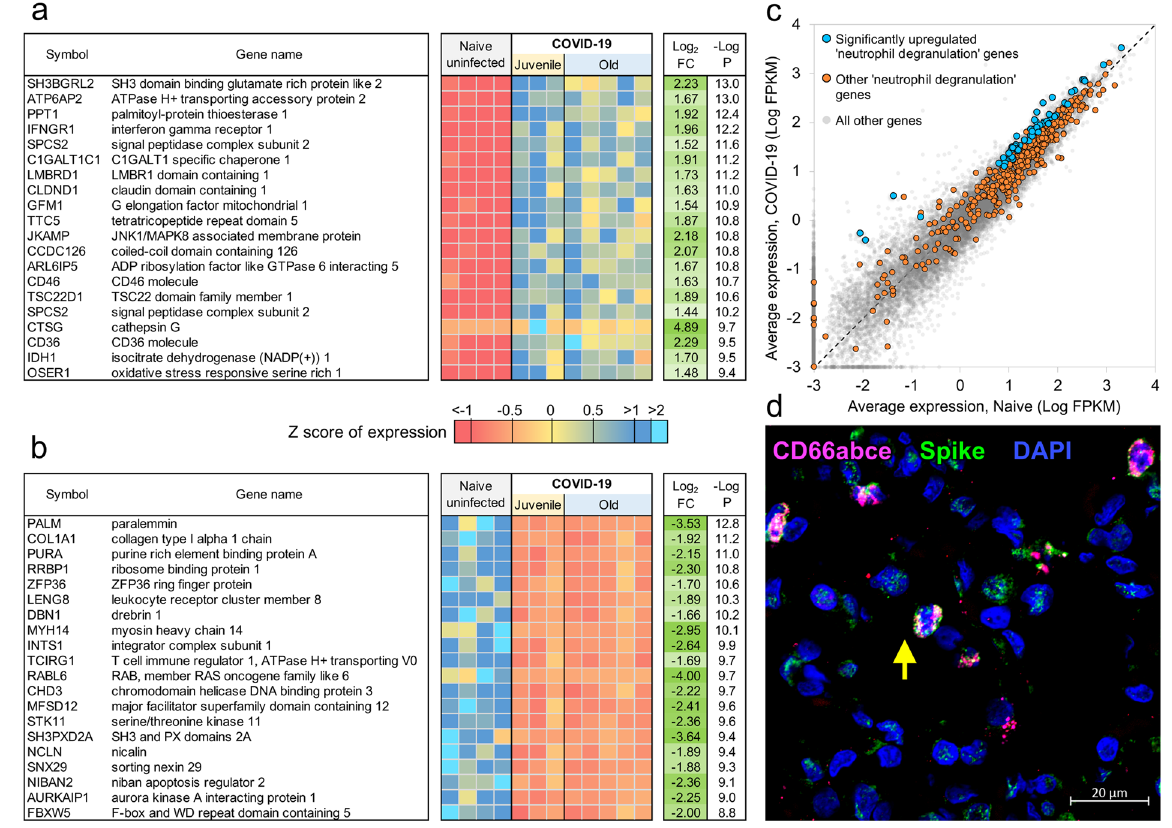
Fig. 2 Genes differentially regulated in SARS-CoV-2-infected macaques represent pathways characteristic of neutrophil degranulation, IFN signaling, collagen degradation and TFG- β signaling. The top 20 most signi fi cantly a upregulated genes and b downregulated genes in SARS-CoV-2-infected macaque lungs. Expression values are visualized by Z scores of normalized expression data (FPKM) per sample, and Log 2 Fold Change and -Log P values are from the DESeq2 output. Genes are sorted by P value. c Gene expression plot showing the relative normalized gene expression levels (FPKM) for each gene, with “ neutrophil degranulation ” (R-HSA-6798695) pathway genes highlighted, including those that were signi fi cantly upregulated during COVID-19 (blue) and those that were not (orange). d Multilabel confocal immuno fl uorescence microscopy of FFPE lung sections from SARS-CoV-2-infected rhesus macaques with SARS-CoV-2 Spike speci fi c antibody (green), neutrophil marker CD66abce (red), and DAPI (blue) at 63X magni fi